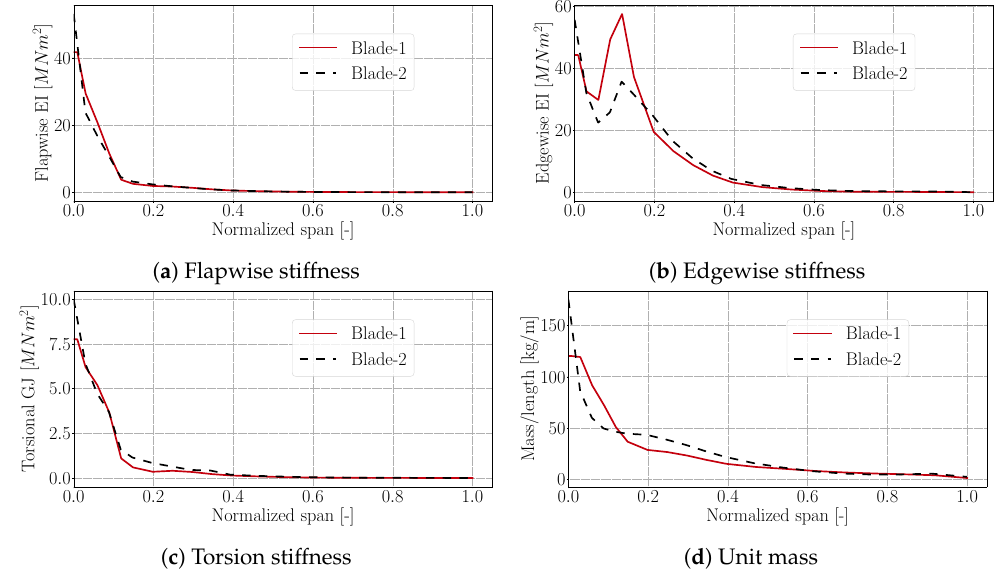
Figure 4. Blade flapwise ( a ), edgewise ( b ), torsion ( c ), stiffness, and unit mass ( d ) along the normalized span for both blade